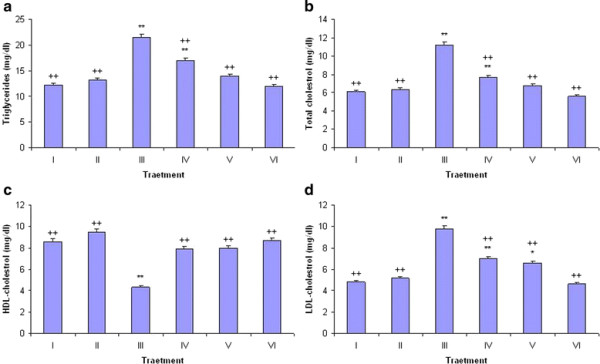
Effect ofLaunaea procumbenson triglycerides (a), total cholesterol (b), HDL-cholesterol (c) and LDL-cholesterol (d); I (Control), II (CCl4), III (100 mg/kg Silymarin + CCl4), IV (100 mg/kg b.w., LPCE + CCl4), V (200 mg/kg b.w., LPCE + CCl4) and VI (200 mg/kg b.w., LPCE alone).